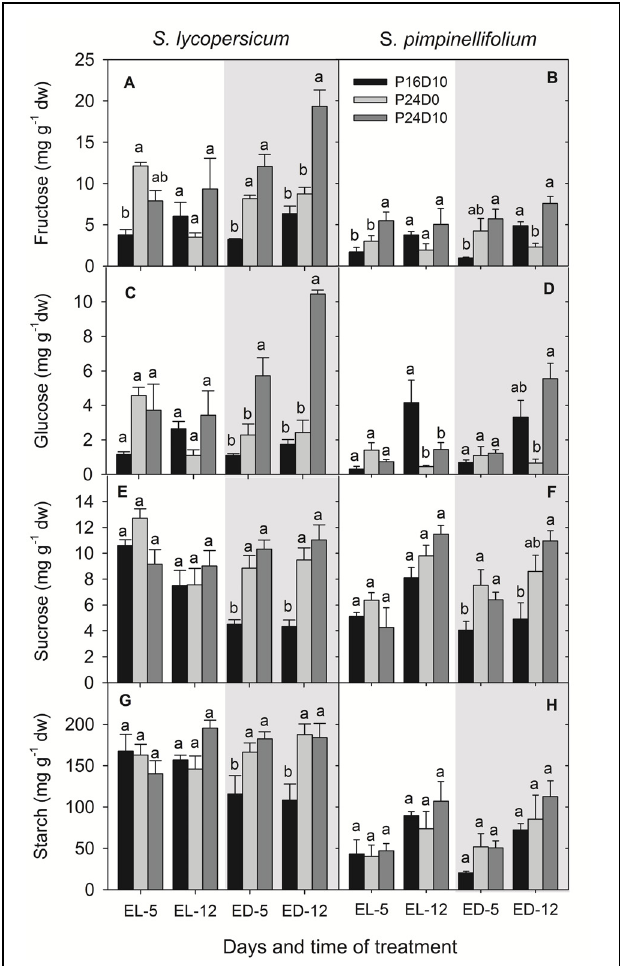
FIGURE 4 | Fructose (A,B), glucose (C,D), sucrose (E,F), and starch (G,H) contents in S. lycopersicum and S. pimpinellifolium leaves at different times of the day in P16D10, P24D0, and P24D10 growth conditions. The data were collected at the end of light (EL, 12:30; white shadow) and at the end of dark (ED, 20:30; gray shadow) of each day. Vertical bars are SEM ( n = 4). Treatment means with different letters within each time of measurement are significantly different and the statistical analysis was done by the Tukey and Waller–Duncan k-ratio t -test.